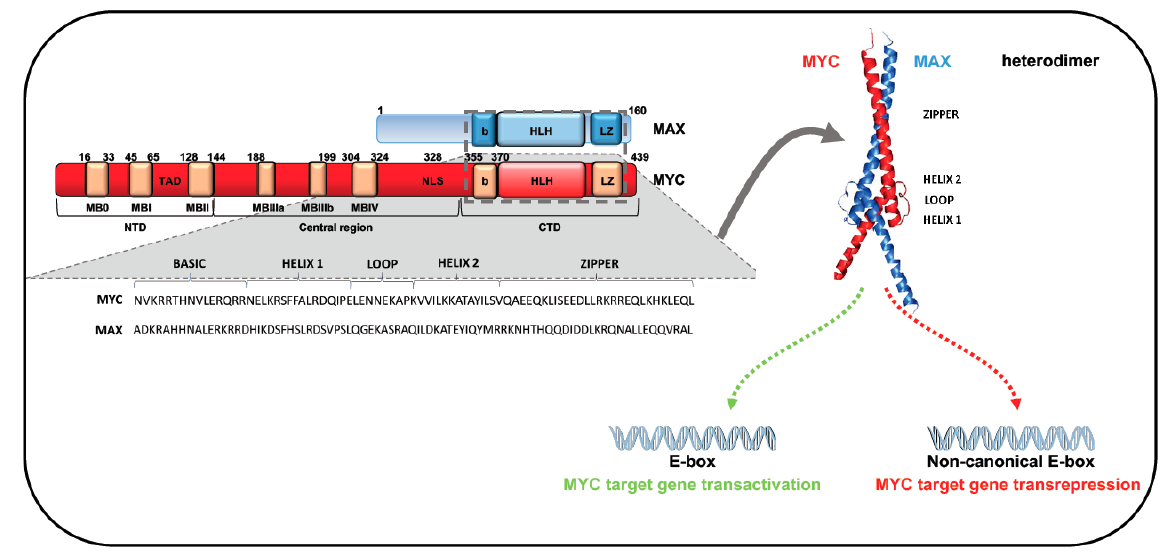
Figure 2. Domain architecture of MYC protein and its interacting partner MAX, showing MYC protein residues and their different functional characteristics. N-terminal region interacts with several partners and C-terminal region binds MAX via b-HLH-LZ motif. MYC:MAX heterodimer binds canonical and non-canonical E-box DNA sequences of target genes.